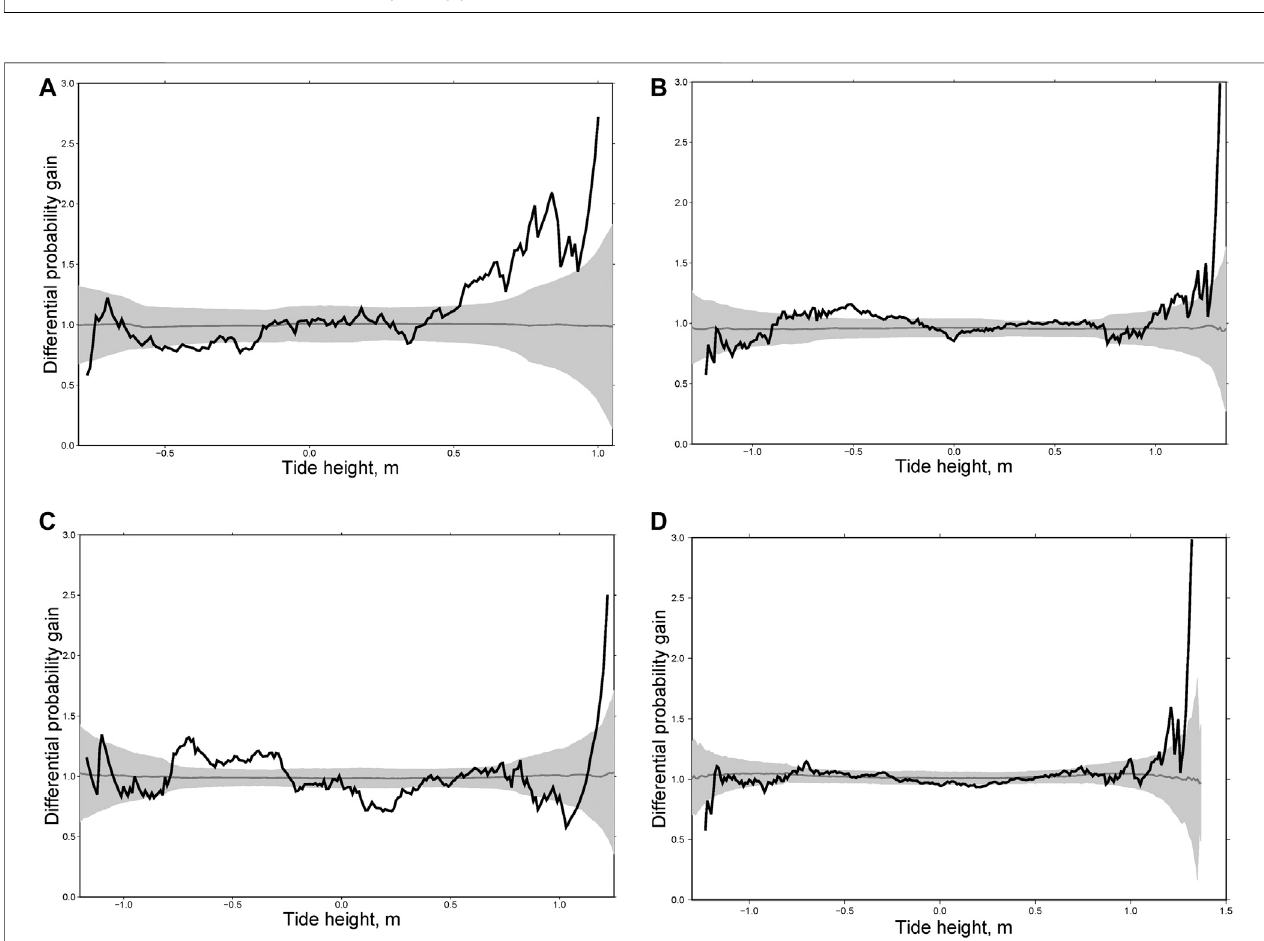
FIGURE10| DifferentialprobabilitygainfunctionsforthreeaftershocksequencesinNew Zealand followingtheearthquakes ofM (cid:1) 7.3, October12,1979 (A) ;M (cid:1) 6.8, August 10, 1993 (B) ; M (cid:1) 7.8, July 15, 2009 (C) and the integral differential probability gain function for fi ve aftershock sequences of thrust type earthquakes (D) .